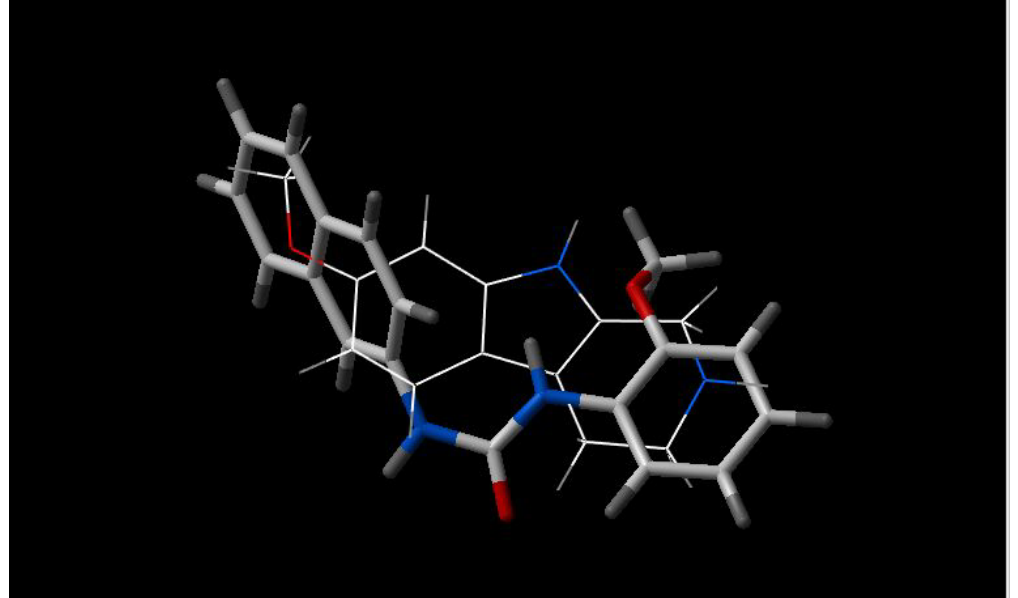
Figure 4. Best fit of optimised INF 271 (sticks) and Reserpine A (wireframe) structures.